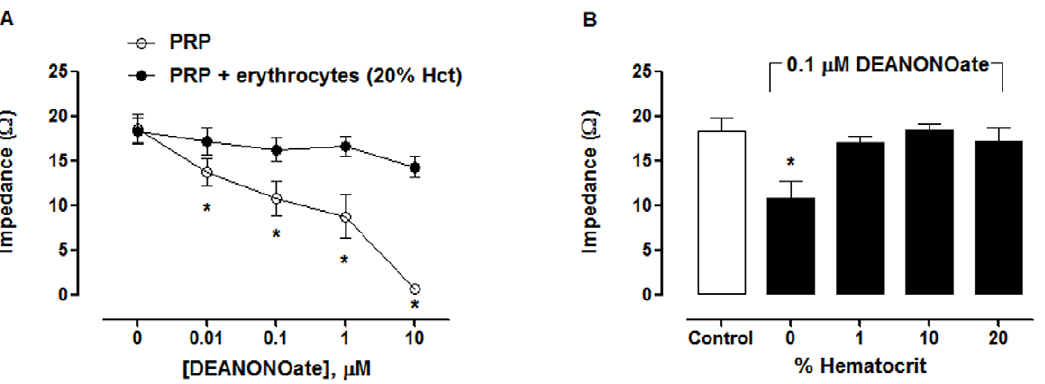
Figure 4. Erythrocytes abolished the effect of DEANONOate on platelet aggregation. (A) Inhibition of platelet aggregation by DEANONOate decreased in the presence of erythrocytes. PRP and PRP + erythrocytes (20% hematocrit) were incubated with DEANONOate for 5 min. (B) Dependence of platelet aggregation in the presence of 0.1 m M DEANONOate on hematocrit. PRP and PRP + erythrocytes (1, 10, and 20% hematocrit) were incubated with 0.1 m M DEANONOate for 5 min. Platelet aggregation was induced by 20 m M ADP. ADP-induced platelet aggregation in the absence of nitrite was shown in the control group * P , 0.05 compared with 0% hematocrit (ANOVA). All experiments were performed at 37 u C. Data are means 6 SEM (n $ 3).